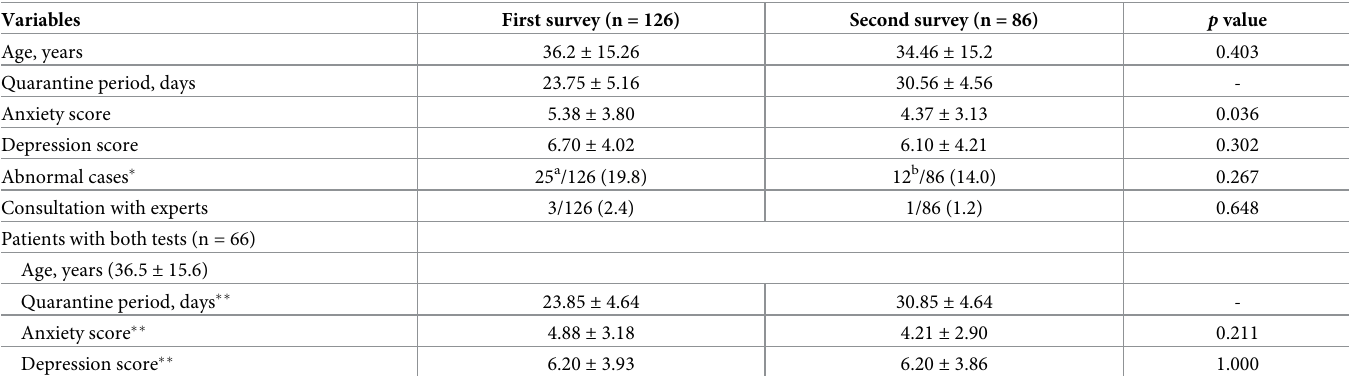
Table 2. Results of Hospital Anxiety and Depression Scale survey in asymptomatic or mildly symptomatic patients with COVID-19.